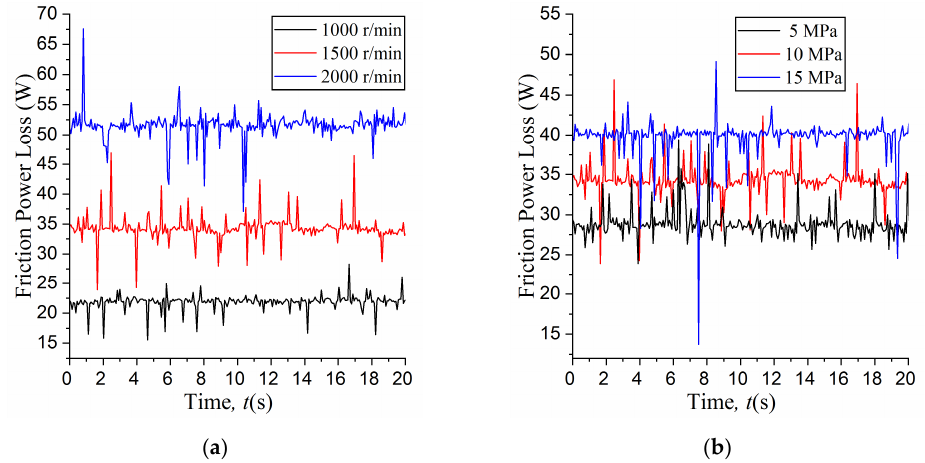
Figure 19. Experimental results of friction power loss of the slipper/swashplate interface. ( a ) Under the working pressure of 10 MPa. ( b ) Under the shaft speed of 1500 r/min.